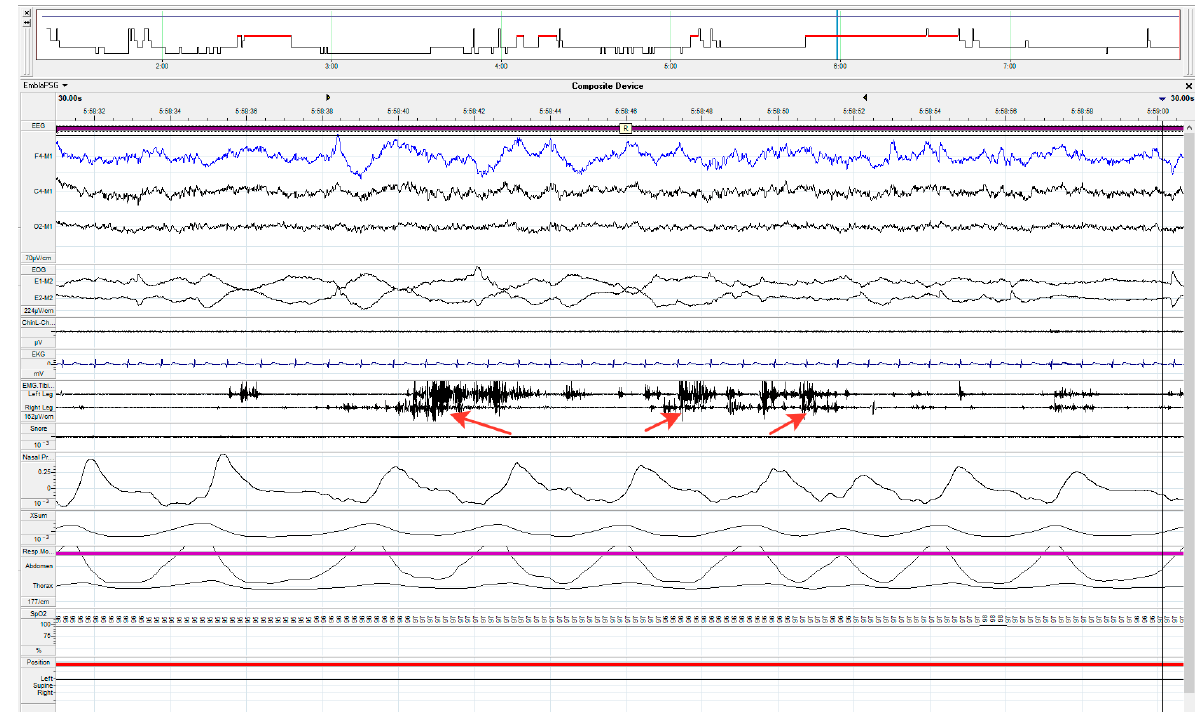
Figure 1. Polysomnography of patient with REM sleep behavior disorder (RBD), 30 s epoch of REM sleep. REM sleep without atonia (RWA). The arrows indicate the transient EMG bursts during REM sleep in the muscle channels (m. tibialis anterior of the left and right legs).